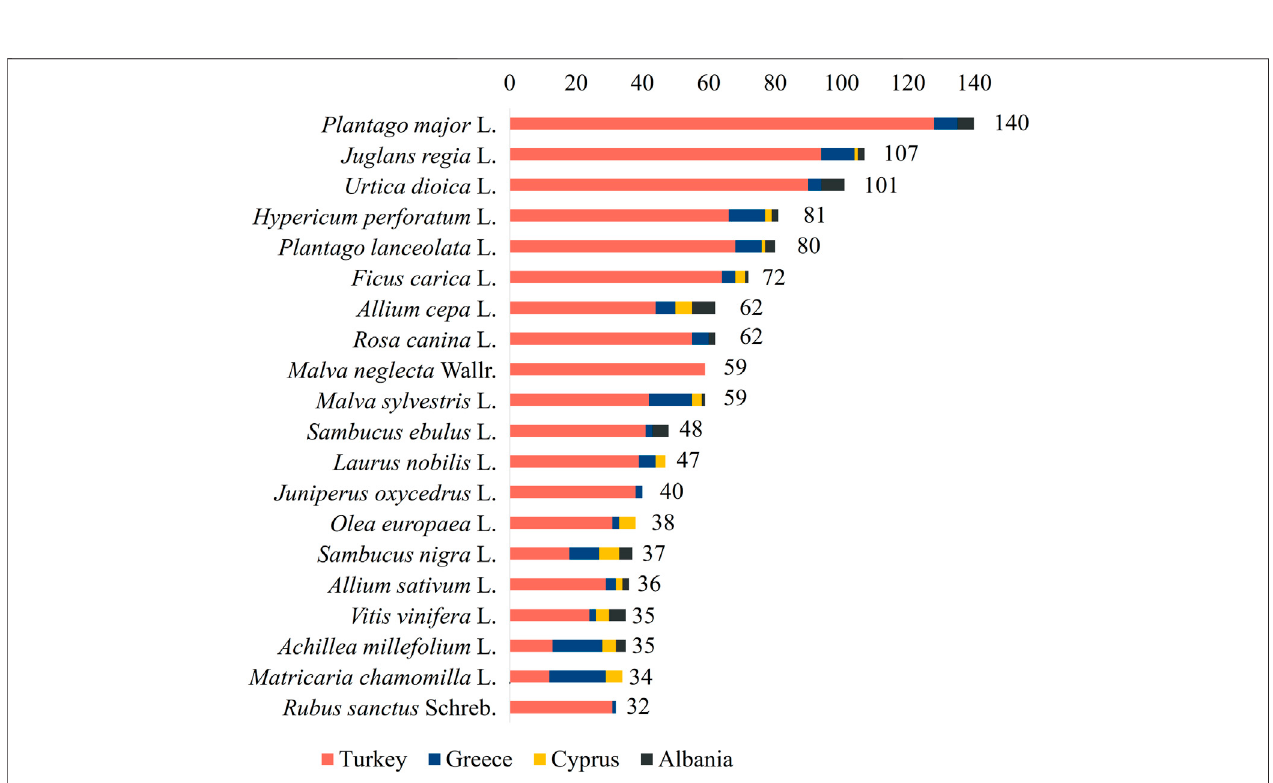
FIGURE 6 | Most cited plant species in relation to skin ailment reports.